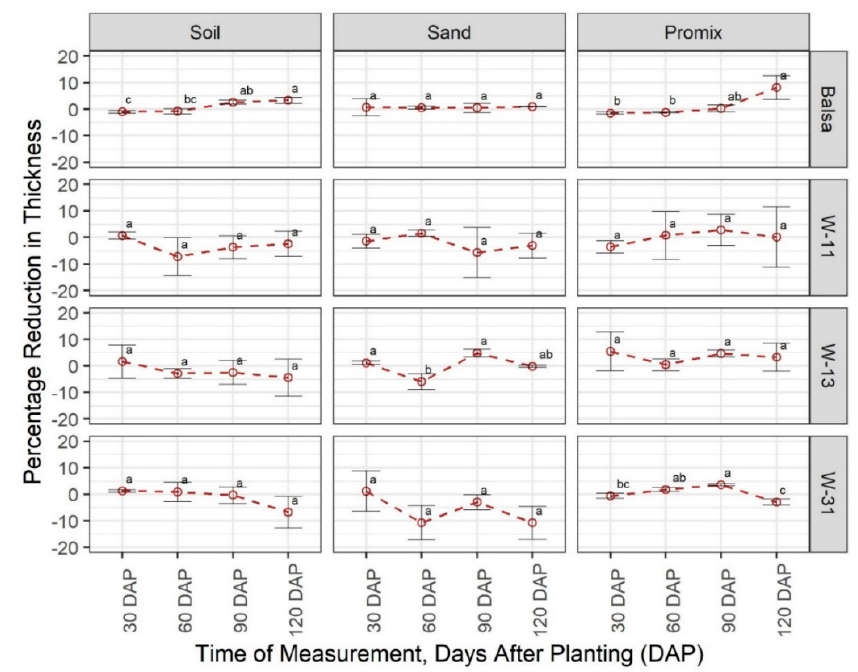
Figure 4. Comparison of percentage change in material thickness in three growing media (Promix,